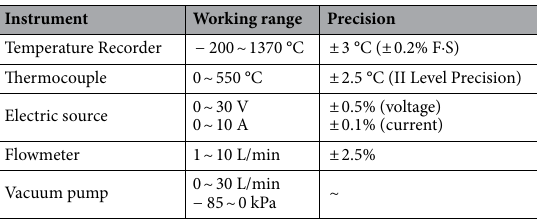
Table 1. The main operational parameters of the scaled-up test